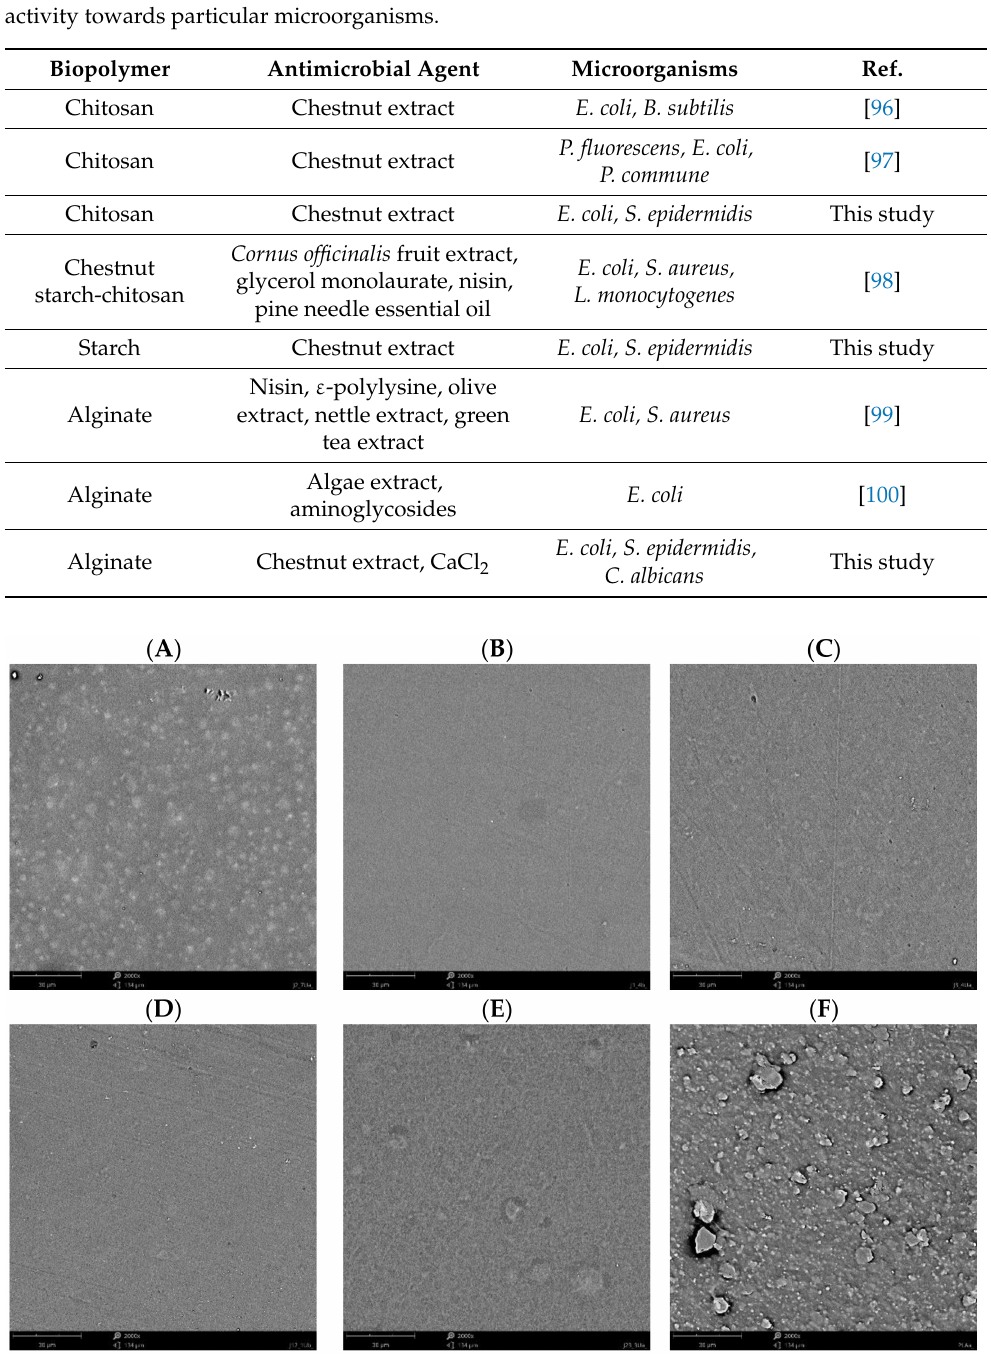
Figure 7. SEM images of: ( A ) starch-based (ST) film; ( B ) chitosan-based (CH) film; ( C ) alginate-based (ALG) film; ( D ) starch and chitosan-based (STCH) film; ( E ) starch and alginate-based (STALG) film; ( F ) commercially available PLA-based